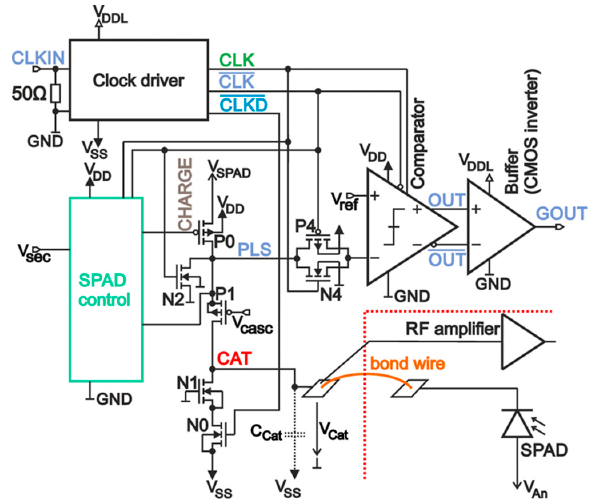
Figure 2. Block diagram of a clocked gating control chip, where a SPAD is connected with a bond wire. A radio frequency (RF) amplifier measures the cathode voltage via a RF probe needle on the pad at node cathode node (CAT).